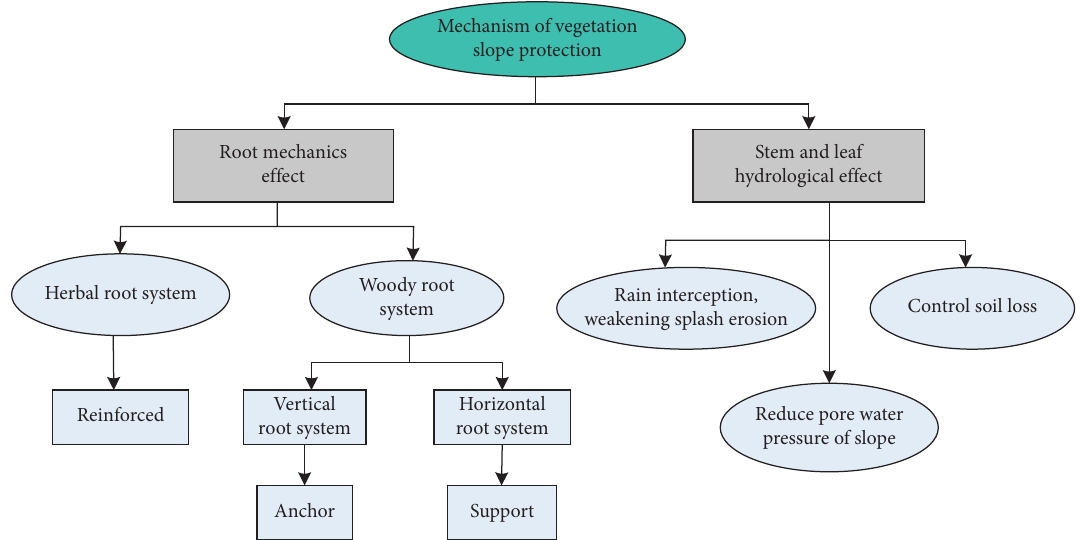
Figure 1: The mechanism structure diagram of ecological gradient protection of